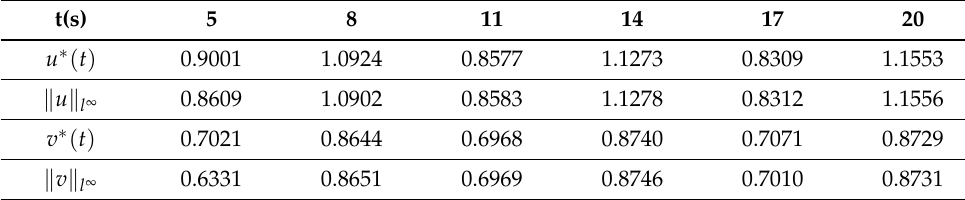
Figure 1. approximate solution for 0, 0.5, 11 and 20 s. Table 1. Values of the asymptotic solutions and l ∞ norms of the numerical